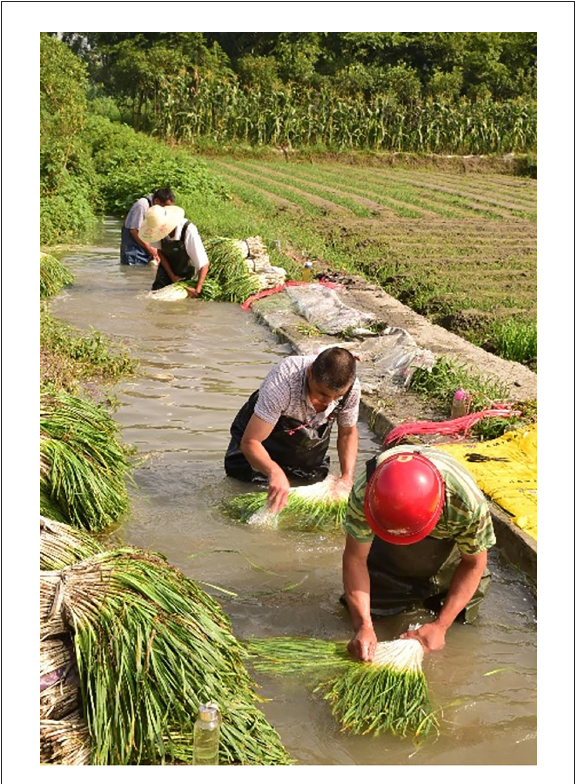
FIGURE2 W Village farmers washing dirt and chemicals off their produce. Photograph by author, July 2017.